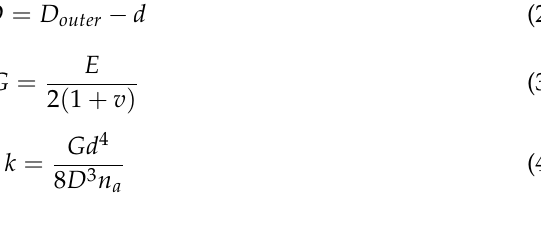
Table 6. Comparison on study comparing factor of safety